Question: Briefly state, in one sentence, what is plotted here.
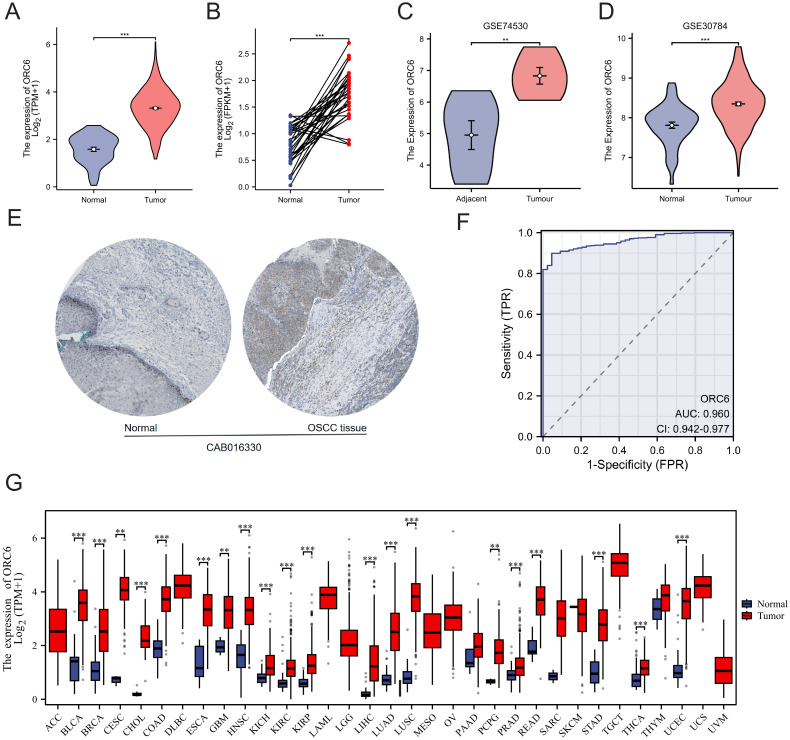
Answer: ORC6 is upregulated in OSCC and shows diagnostic potential. (A) ORC6 expression in tumor and normal tissues in the TCGA-OSCC cohort. (B) Comparison of ORC6 expression between OSCC tumors and matched normal tissues in the TCGA cohort. (C) Validation of differential ORC6 expression between tumor and adjacent non-tumor tissues in the GSE74530 dataset. (D) Validation of differential ORC6 expression between tumor and normal tissues in the GSE30784 dataset. (E) Representative immunohistochemical staining images of ORC6 in normal oral epithelium and OSCC tissues from the Human Protein Atlas. (F) Receiver operating characteristic (ROC) curve evaluating the performance of ORC6 in distinguishing tumor from normal tissues in the TCGA-OSCC cohort. (G) Pan-cancer overview of differential ORC6 expression across cancer types in the TCGA-GTEx dataset. #*P < 0.05, **P < 0.01, and ***P < 0.001.